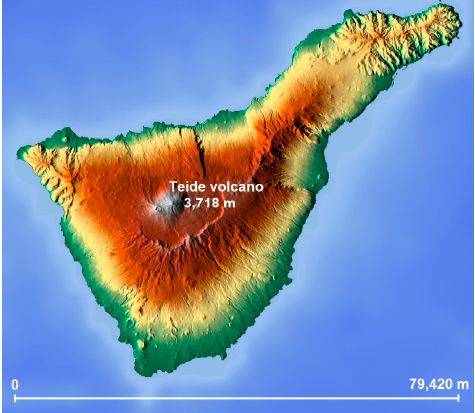
Figure 2 . Orographic model of the Tenerife Island (Google Maps). Figure 2. Orographic model of the Tenerife Island (Google